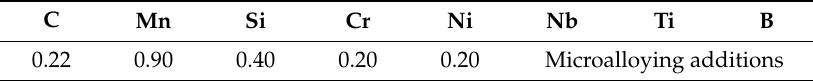
Table 1. Chemical composition of the used steel, in weight